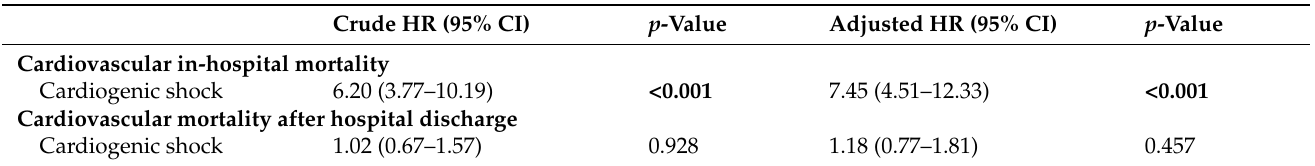
Table 3. Crude and adjusted effects of cardiogenic shock on cardiovascular in-hospital and long-term mortality.